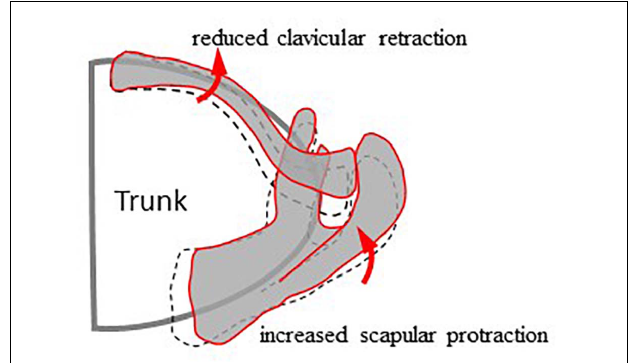
FIGURE 6 | Schematic diagram showing the different kinematics of the scapula and clavicle between the surgical (red lines) and healthy control (black dash lines) groups during arm elevation in the frontal plane. Compared to healthy controls, the surgical group showed reduced clavicular retraction and increased scapular protraction during frontal plane arm elevations while maintaining unaltered scapular rotation and